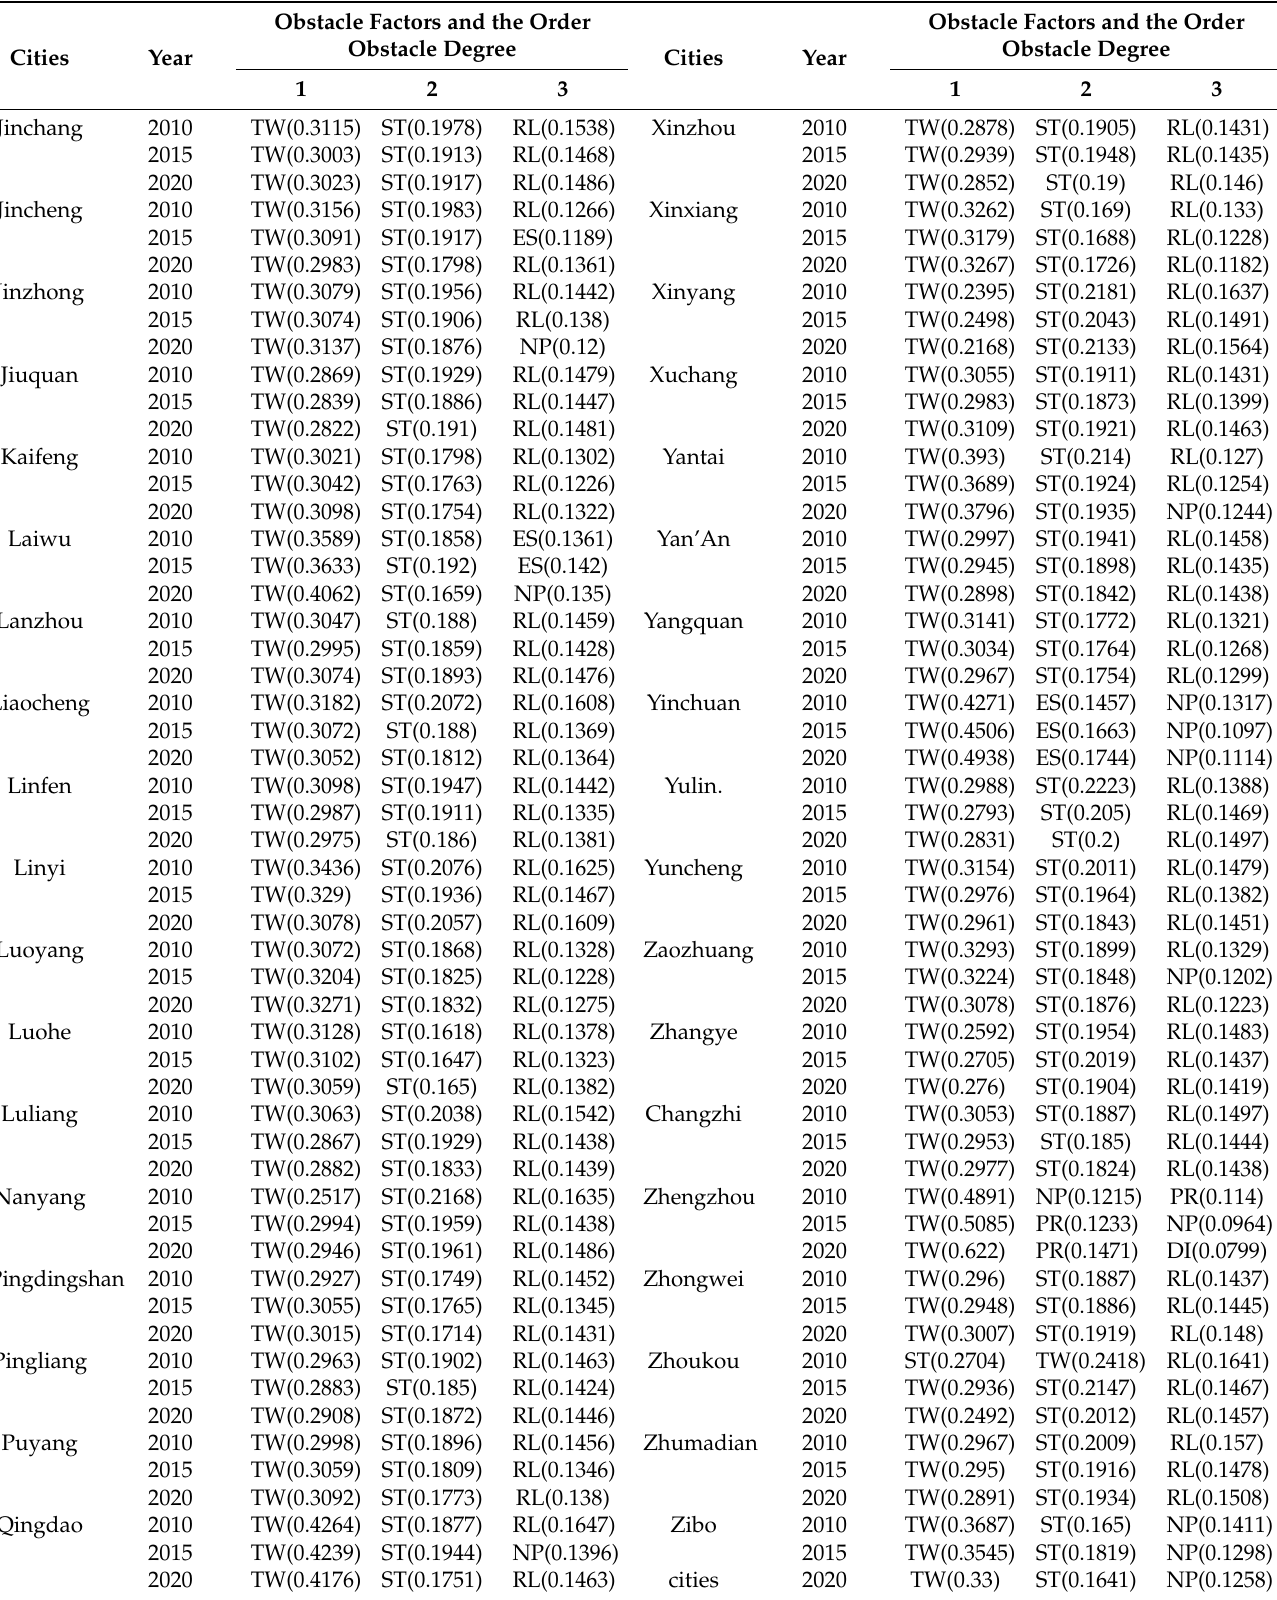
Table A3. Main obstacle elements and order of their degree of impact on the suitability of urban living in the YRB from 2010 to